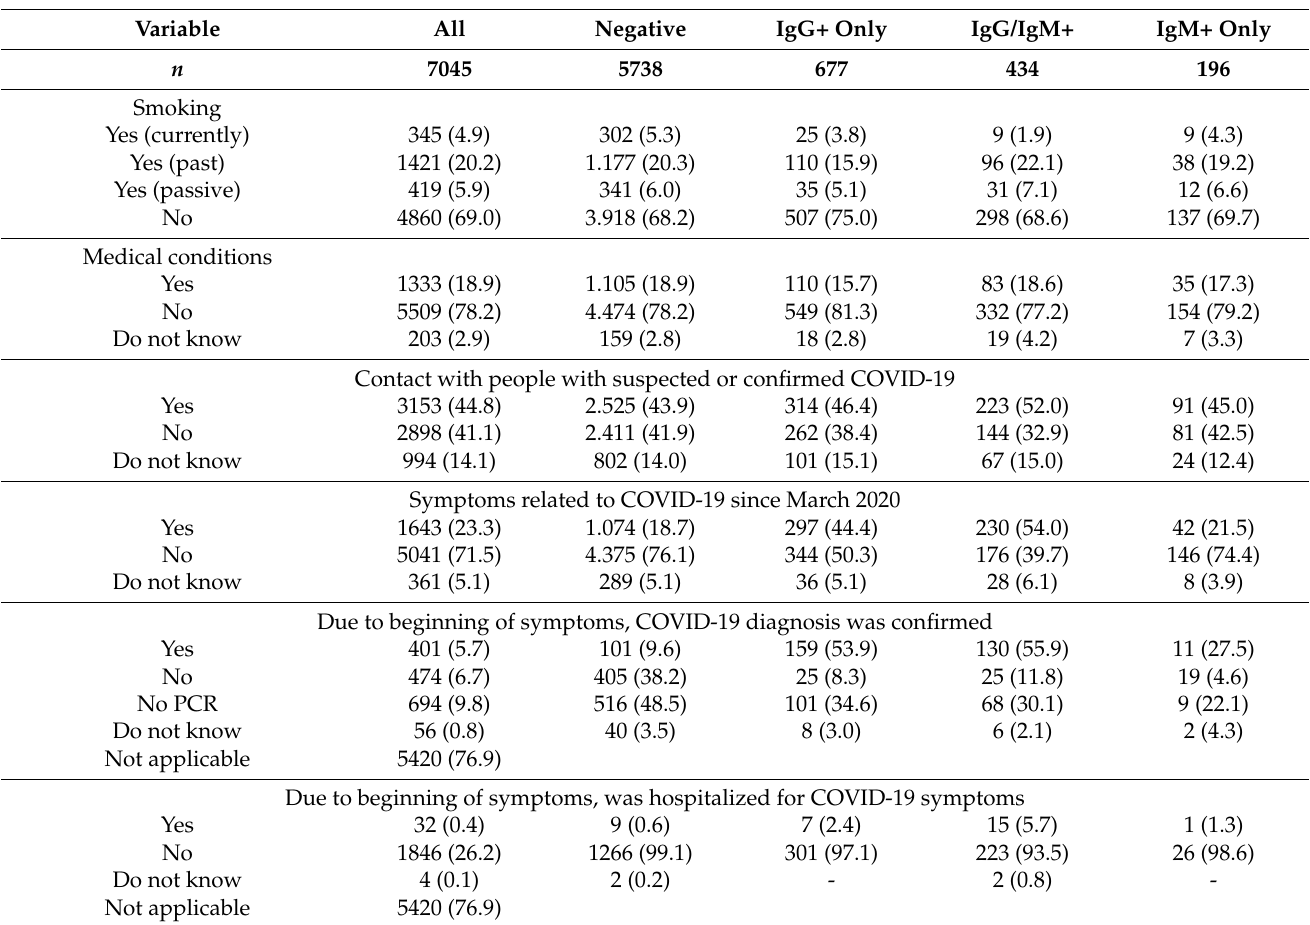
Table 2. Clinical and SARS-CoV-2 exposure variables according to immunoglobulin type a .